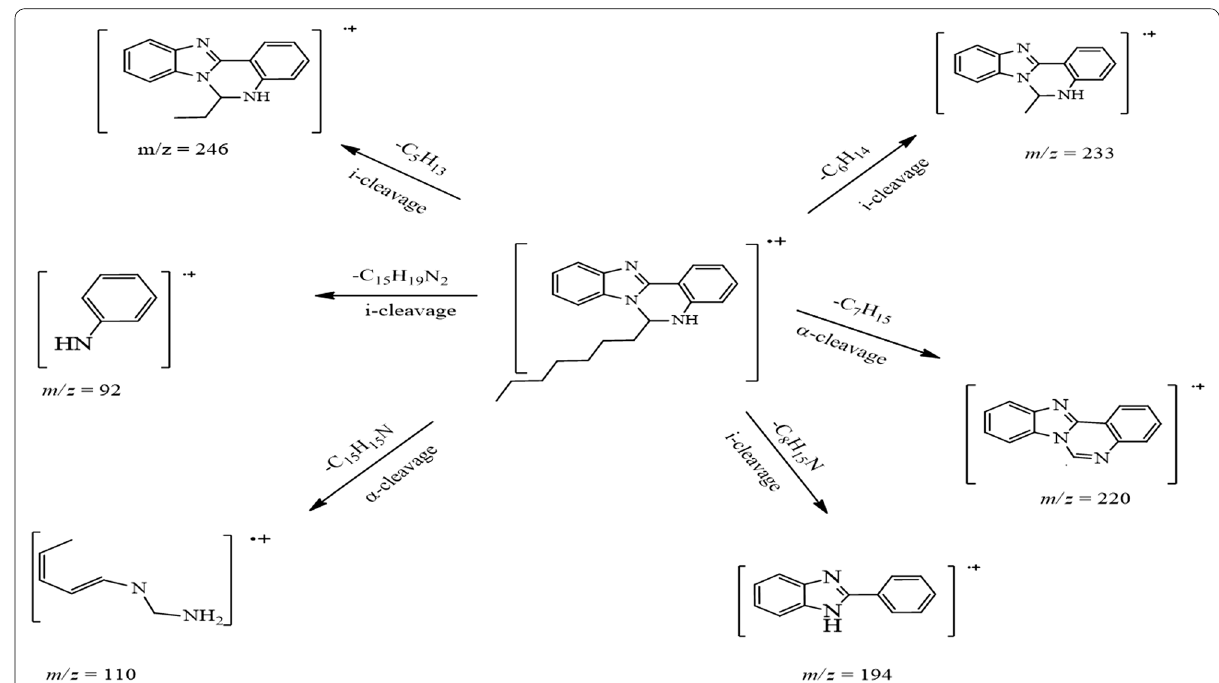
Fig. 8 Fragmentation pattern of